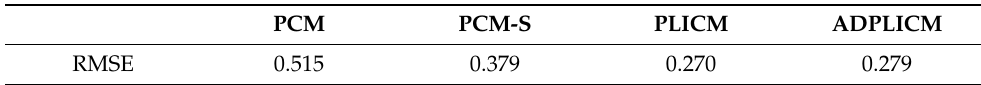
Figure 19. The membership fraction image for the ‘Wheat’ class generated by ( a ) PCM, ( b ) PCM-S, ( c ) PLICM, and ( d ) ADPLICM algorithms. Table 5. RMSE values of PCM-based classifiers for single class (‘Wheat’) extraction.